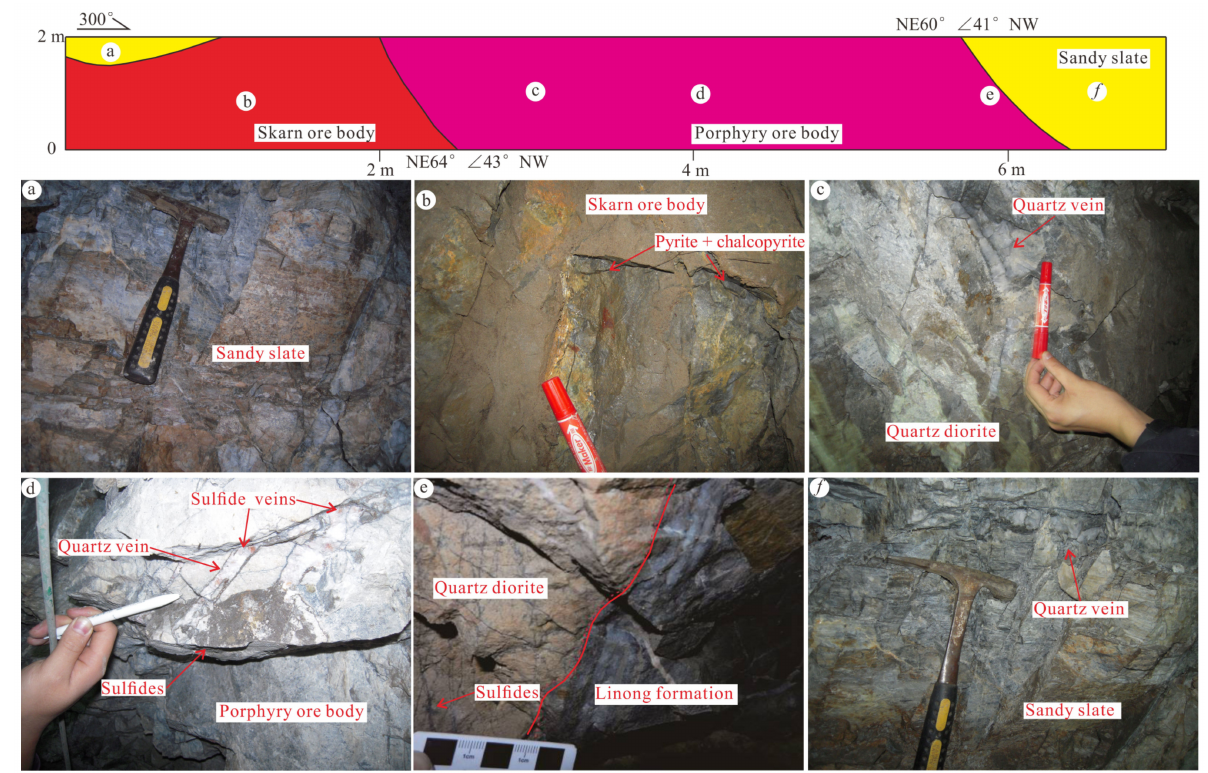
Figure 3. The sketch map of 41 # -1 mining stope at underground tunnel 3250 m section in the Yangla Cu-W polymetallic deposit [13]. ( a ) The weak skarnization and silicification sandy slate; ( b ) The high- grade skarn ore body and developed disseminated pyrite and chalcopyrite; ( c ) The quartz diorite, which developed a large number of quartz veins; ( d ) The porphyry ore body, which developed vein-disseminated metal sulfides (pyrite, chalcopyrite, and sphalerite) and quartz veins; ( e ) The irregular contact line of the quartz diorite and sandy slate, which developed veins metal sulfides in the quartz diorite, and there are many quartz veins in the sandy slate of Linong Formation; ( f ) The sandy slate, which developed the later quartz